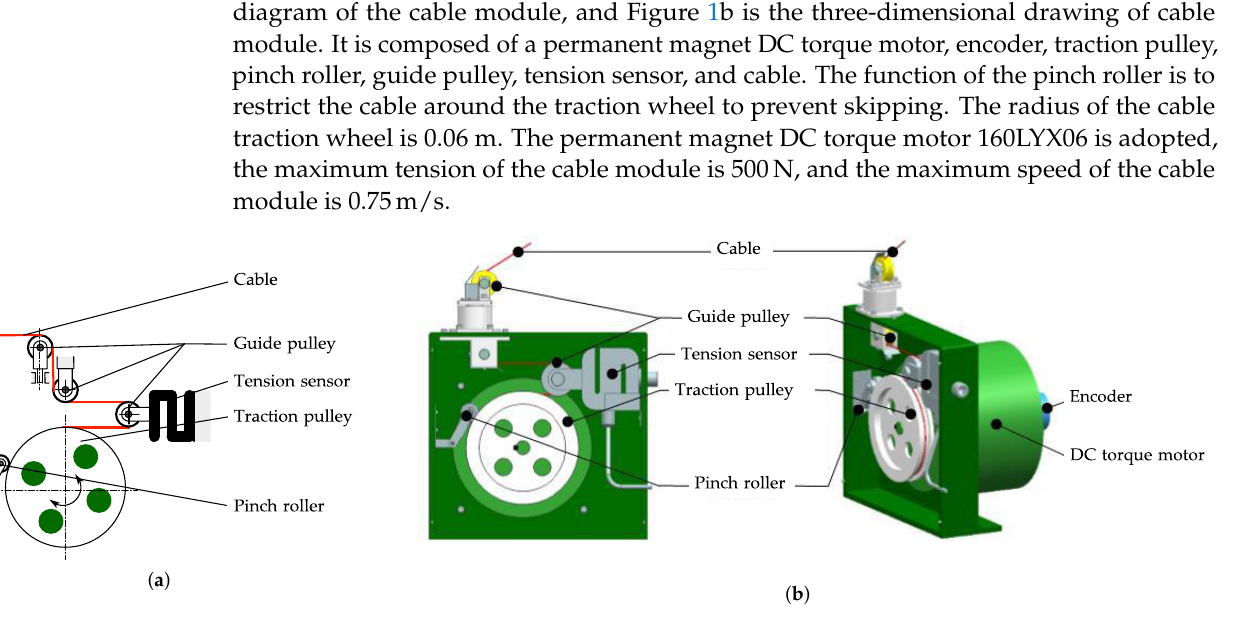
Figure 1. Cable module. ( a ) schematic diagram of cable module; ( b ) 3D drawing of the cable